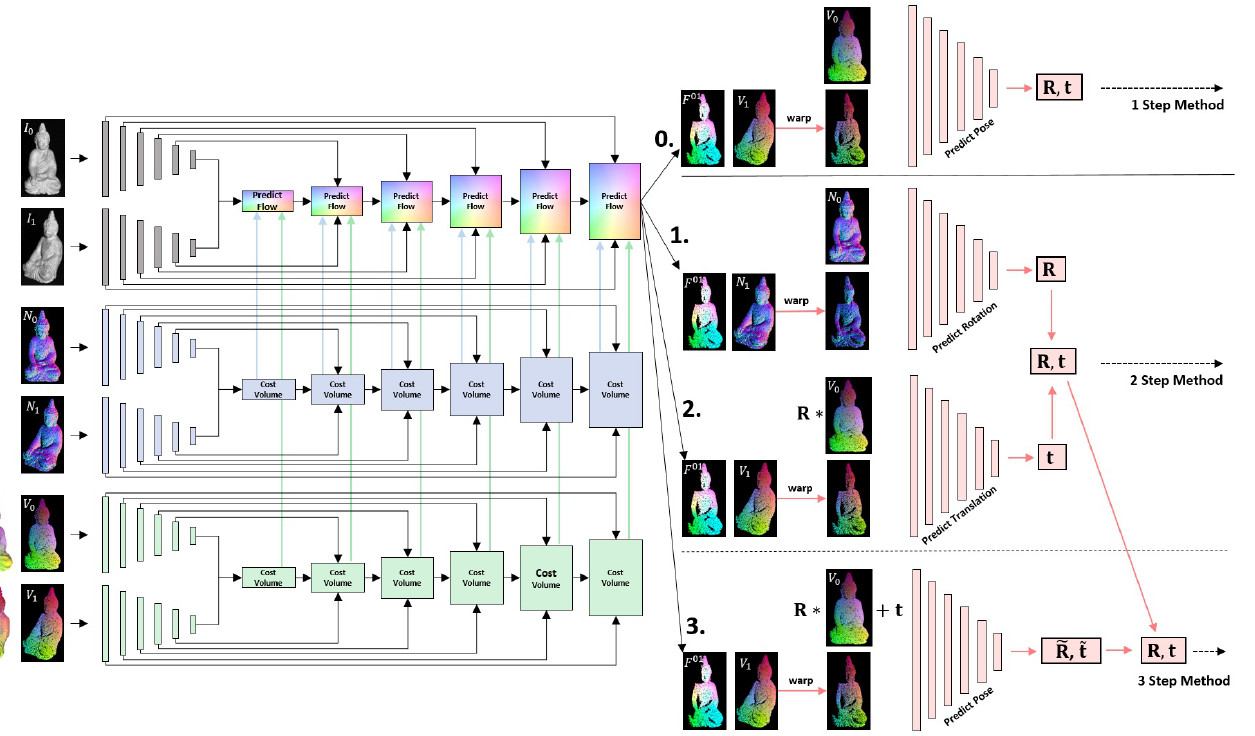
Figure 9. Architecture of Flow2PoseNet . The left part of the network aims to predict accurate optical flow from images, normal- and vertex-maps, using textural features from images, shading features from normals and geometrical features from vertices in order to predict accurate and light resistant flow fields. The pose of the rigid scene is computed in three steps from the warped normal- and vertex-maps. The first step predicts the normals from the warped normal-maps. The second step predicts the translation from the warped and rotated vertex-maps. The third step predicts a correction transformation to refine the predicted rotation and translation